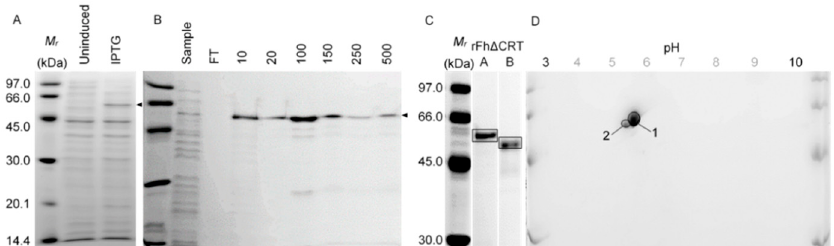
Figure 1. Expression, purification and proteomic analysis of recombinant truncated Fasciola hepatica calreticulin (rFh ∆ CRT). Fh ∆ CRT -pET-28b( + ) BL21(DE3)pLysS lysates (5 µ g) before and after 0.5 mM isopropyl β - d -1–thiogalactopyranoside (IPTG) induction were analysed by 1-DE ( A ) before immobilised metal ion chromatography (IMAC) purification using HIS-Select ® Cobalt resin ( B ) over two operations conducted at pH 6.0, followed by further purification at pH 8.0 (not shown), to remove co-elutants with the target rFh ∆ CRT, indicated by the arrow. Transient dimorphism of rFh ∆ CRT at